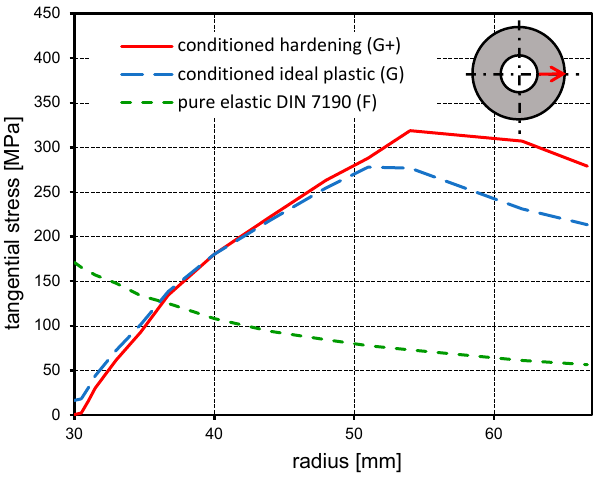
Figure 6. Tangential stresses in the stress states of the points F elast , G , and G + with a safety against plastic deformation of the outer part S PA = 1.5 = S + PA ( S + PA → after hardening of the material).